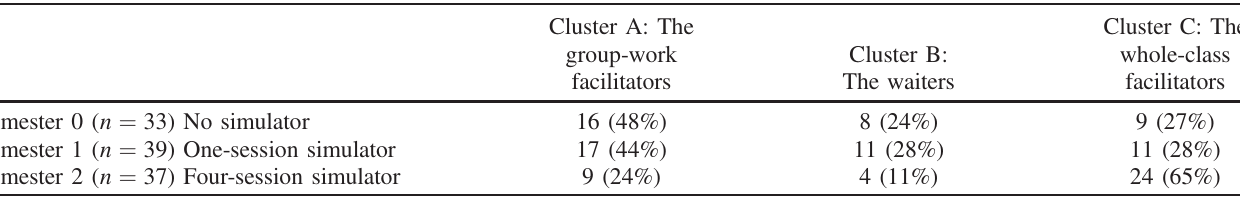
TABLE VI. Distributions of class periods observed in each cluster in different semesters with various number of simulator